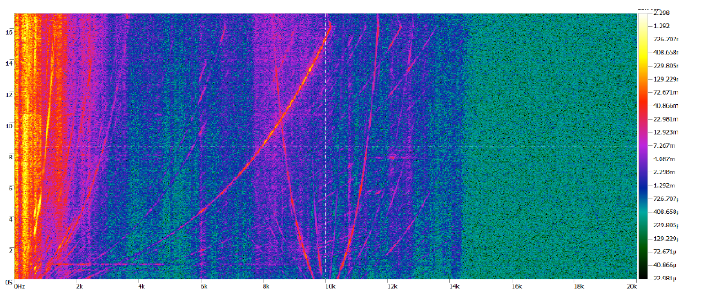
Fig. 15. Order analysis of motor mount vibration (at frame) along z direction of vehicle coordinate system (Acceleration condition). Table 3. Vibration isolation rate of motor mount(Isolation rate =1- Effective value of vibration acceleration of body / Effective value of motor vibration acceleration) The vehicle speed displayed with the instrument cluster (km/h) 40 50 60 90 100 The vehicle speed measured with